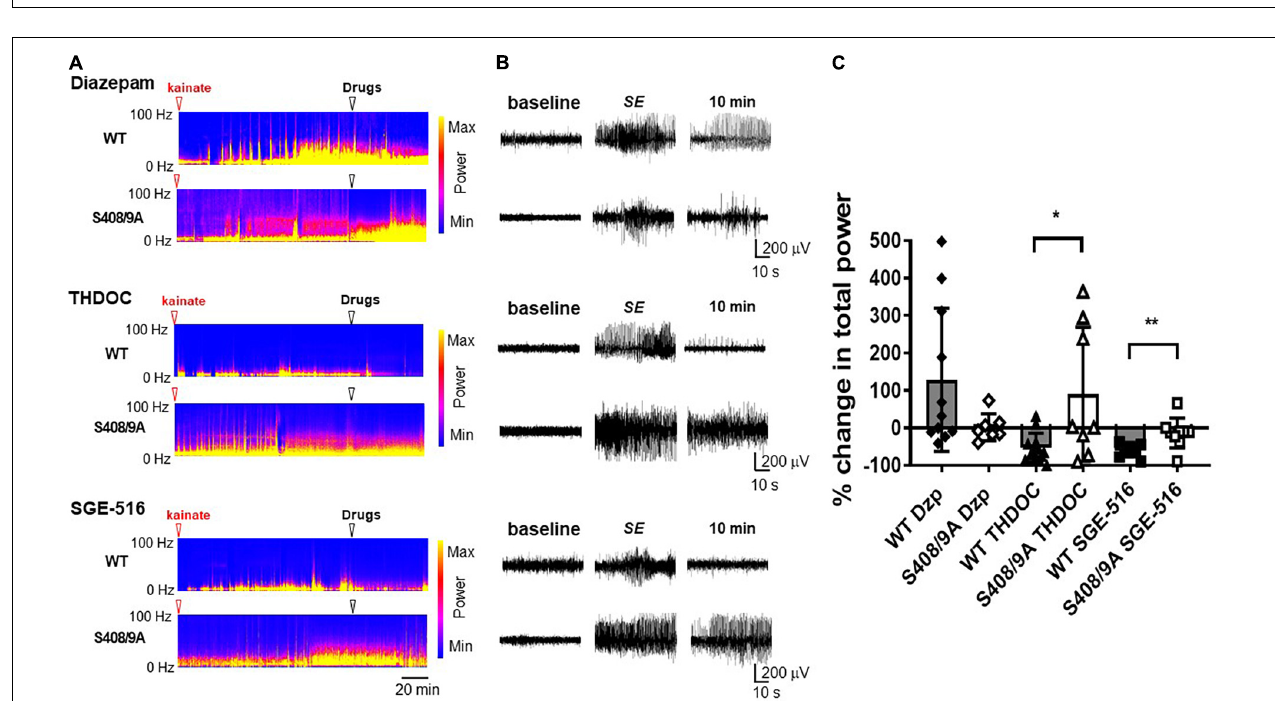
FIGURE 3 | Hypnotic actions of THDOC are decreased in S408/9A mice. Hypnotic action of THDOC was measured using the loss of righting reflex assay, 44% of S408/9A mice tested did not lose their righting reflex with THDOC. Bars represent only the responders. (A) Induction of LORR with i.p. injection of 80 mg/kg THDOC was similar in WT and S408/9A mice. (B) The S408/9A mice spent a significantly shorter duration of loss of righting reflex compared to WT controls following THDOC (* p = 0.03; t -test; n = 5–6).